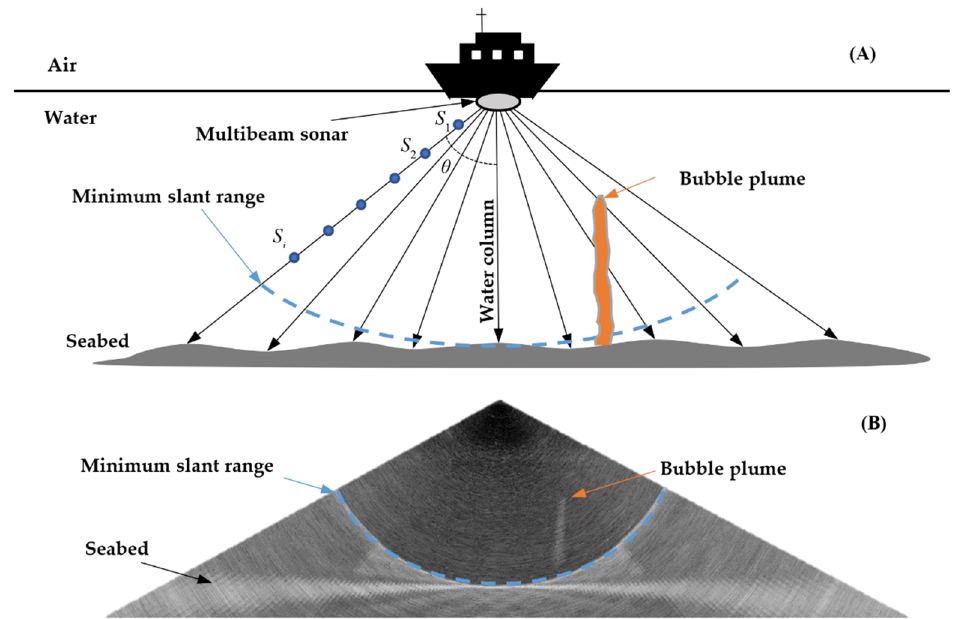
Figure 1. Bubble plume detection in multibeam water column image. ( A ) is the principal diagram of target detection in multibeam water column images, where S i is the sampling point at equal time intervals and θ is the beam incident angle; ( B ) is the measured multibeam water column image containing the bubble plume target.